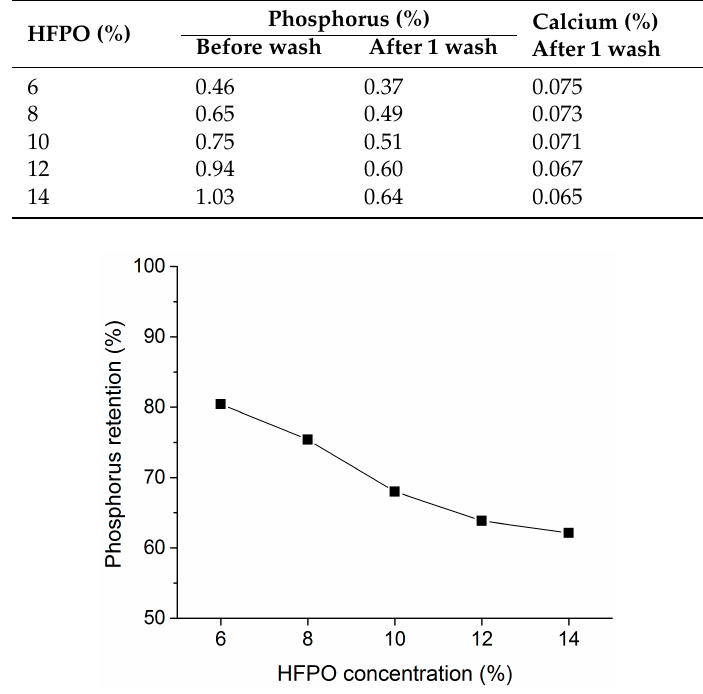
Figure 3. The phosphorus retention of the Nomex ® /cotton fabric treated with 3% BTCA and HFPO with different concentrations, cured at 170 °C for 3 min and finally subjected to one home laundering cycle.